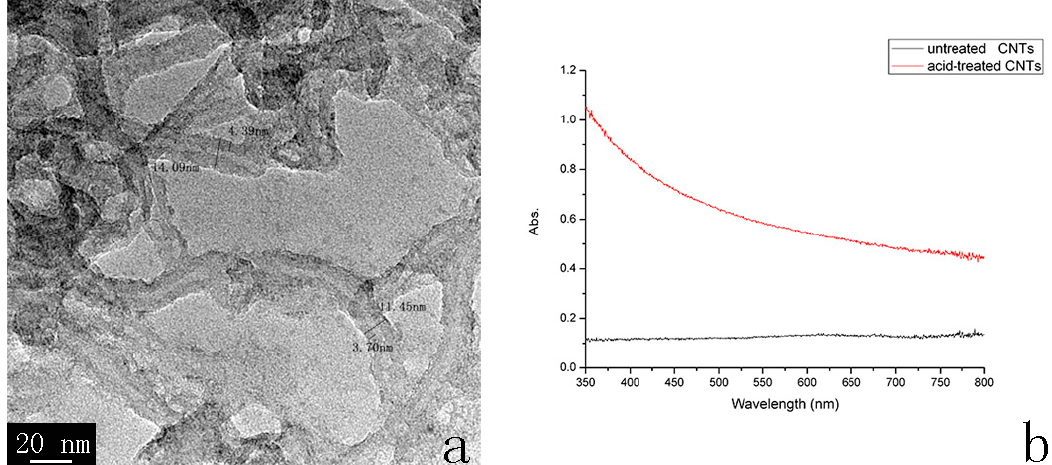
Figure 2. ( a ) TEM image of carbon nanotubes (CNTs); ( b ) UV–vis spectra of the untreated and base-treated CNTs.